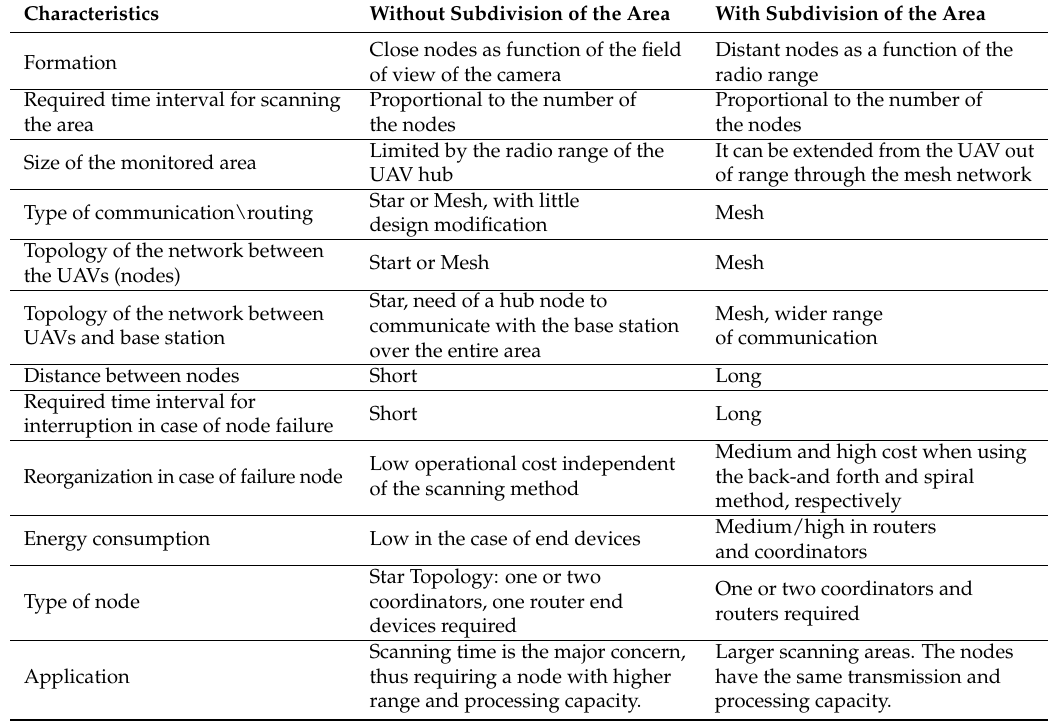
Table 1. Characteristics of the Multi-UAV communication network for the proposed scanning strategies.